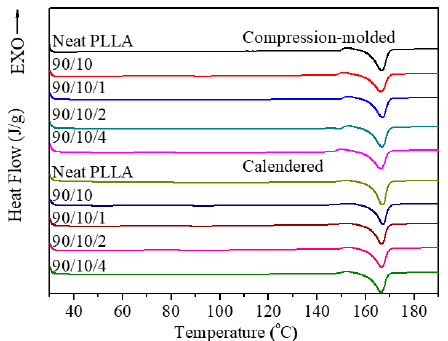
Figure 10. DSC traces of annealed PLLA and PLLA / EPDM / OMMT (90 / 10 / x) samples prepared by compression-molding and calendering.